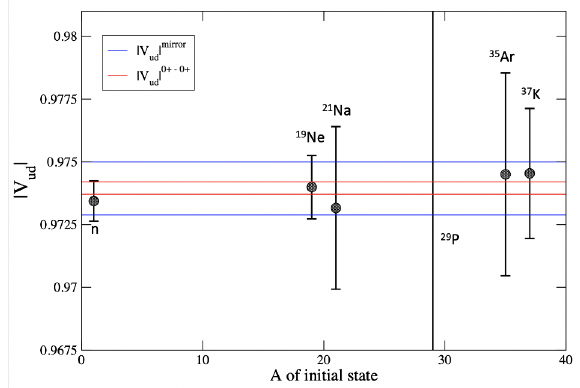
Figure 1. | V ud | from neutron lifetime measurements, 0 + to 0 + Fermi decay (red error bar), and mixed-mirror decay (blue error bar). Data from Ref. [1], including latest theoretical